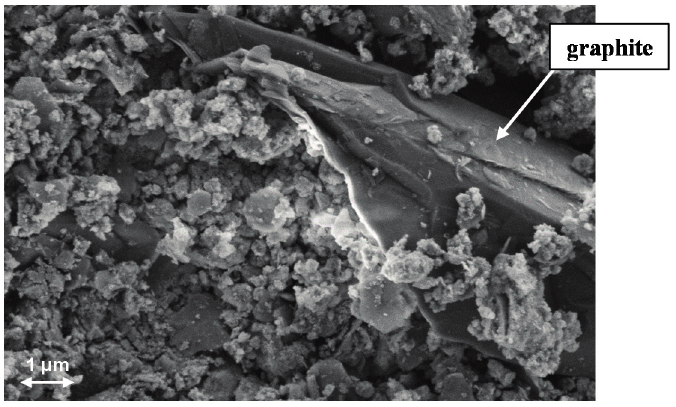
Figure 6. SEM image from the catalyst